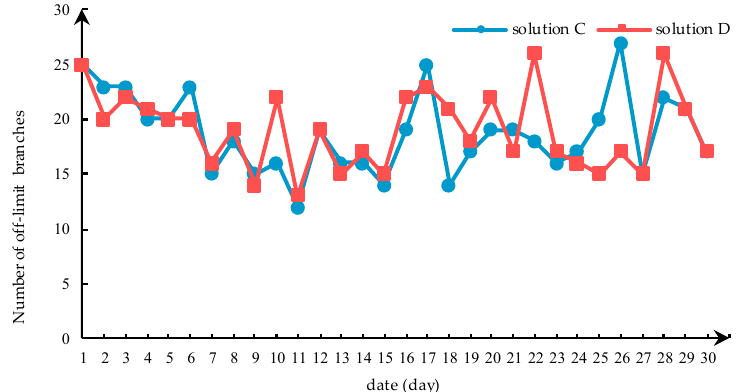
Figure 14. O ff -limit branch power flow during the maintenance period in Hubei Figure 14. Off-limit branch power flow during the maintenance period in Hubei Province.